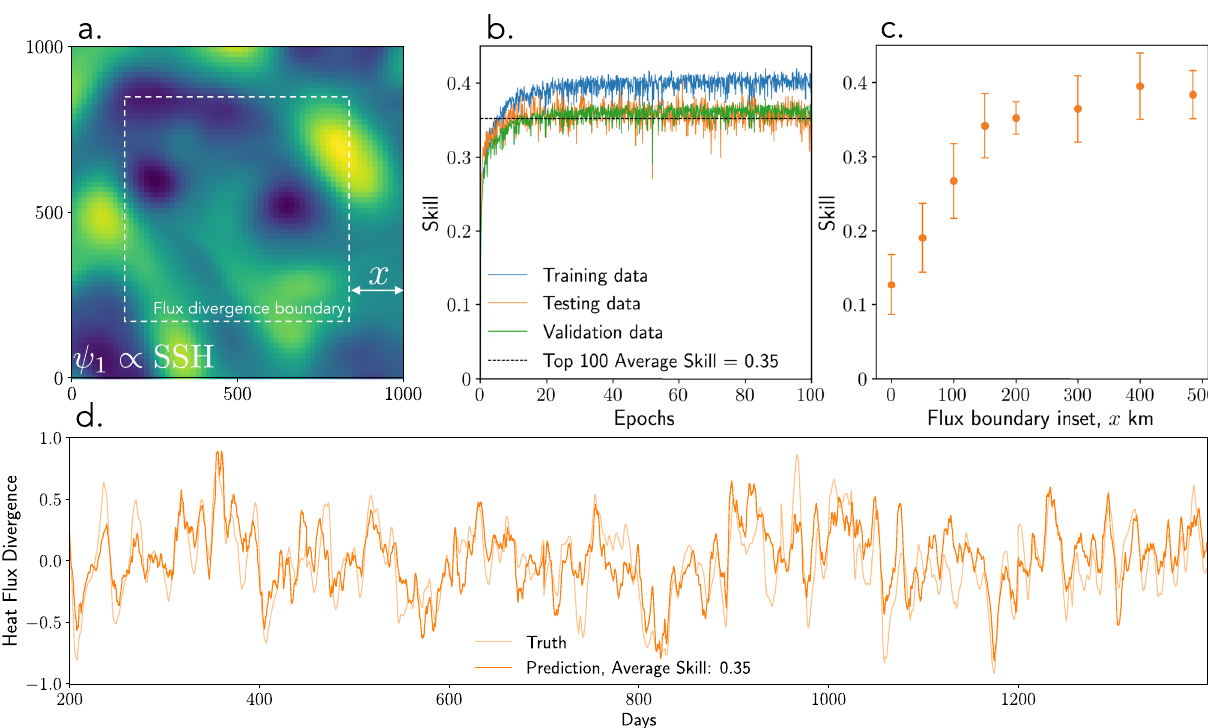
Fig. 4 Performance of the convolutional neural network in predicting the divergence of the eddy heat fl ux. a An example of an input sea surface snapshot and the inset region separated by a distance x over which the output is calculated as the inset-averaged divergence of the eddy heat fl ux; colorscale and range is the same as in Fig. 1. b The evolution of the training (blue), validation (green), and testing (orange) skills as a function of training epochs for the case of x = 200 km. The average validation skill corresponding to the top 100 best training skill is shown in gray dashed line. c The sensitivity of the prediction skill on the proximity ( x ) of the inset to the boundaries of the sea surface height domain; note that x ≈ 500 km corresponds to point estimate of the eddy heat fl ux divergence. The error bars represent a range in the validation skill corresponding to the top 100 best training skills. d Example time series showing the fl uctuations of the true (thin orange line) and predicted (thick orange line) heat fl ux divergence for the case of x = 200